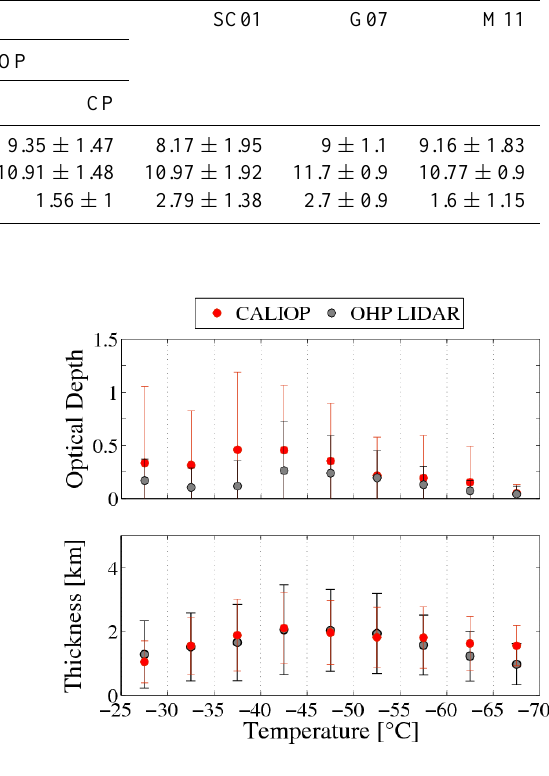
Fig. 10. Average optical depth (top) and geometrical thickness (bottom) in 5°C intervals of mid-cloud temperature. Results presented in red correspond to CALIOP and those in gray to the OHP ground-based lidar.